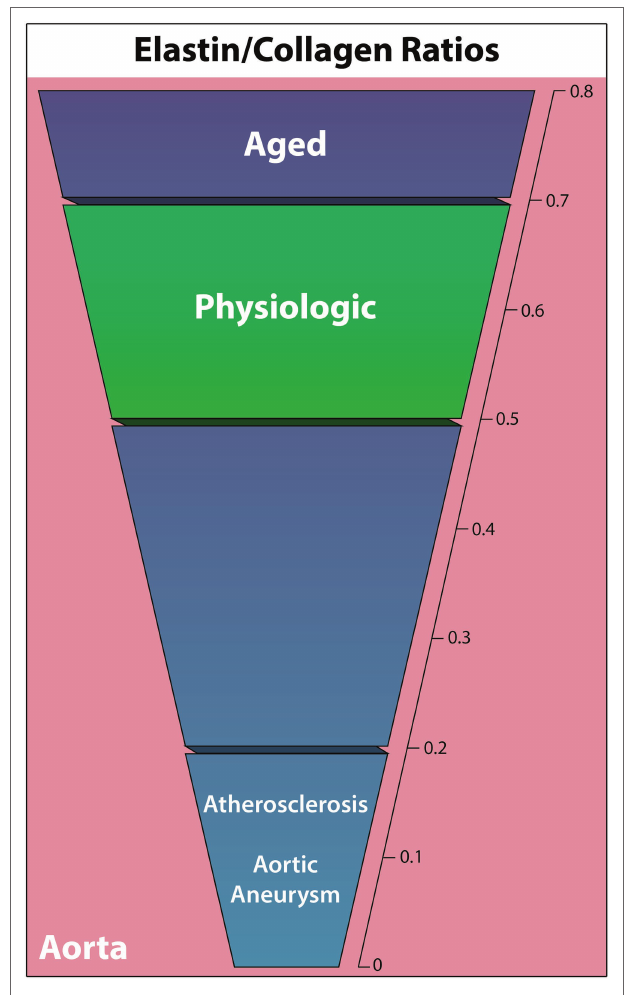
FIGURE 2 | Elastin to collagen ratios in the human complete aortic wall in cardiovascular diseases, the aged individuum, and the physiologic situation. Elastin relative to collagen is noted to decrease in all non-physiologic cases other than